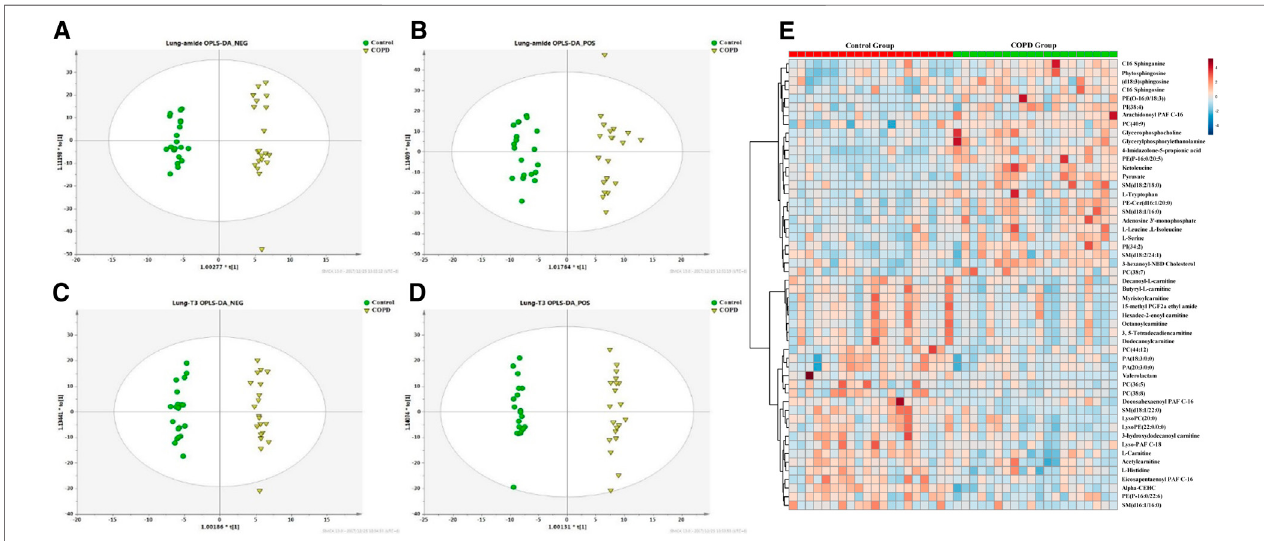
FIGURE 1 | The OPLS-DA model for classifying COPD patients versus controls displayed signi fi cant group deviation in Discovery set. (A) The score plot of the amide method in negative mode. (B) The score plot of the amide method in positive mode. (C) The score plot of the T3 method in negative. (D) The score plot of the T3 methodinpositivemode. (E) Theheatmapshowed52differentiallyabundantmetabolitesoftheCOPDpatientscomparedwiththecontrolsindiscoveryset,theredcolor indicated higher expression level in COPD and the blue color indicated lower expression level in COPD. OPLS-DA, orthogonal partial least squares-discriminant analysis. COPD, chronic obstructive pulmonary